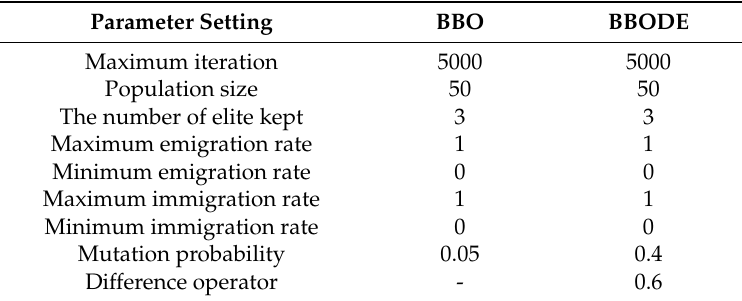
Table 3. The experiment parameters of BBO and BBODE.